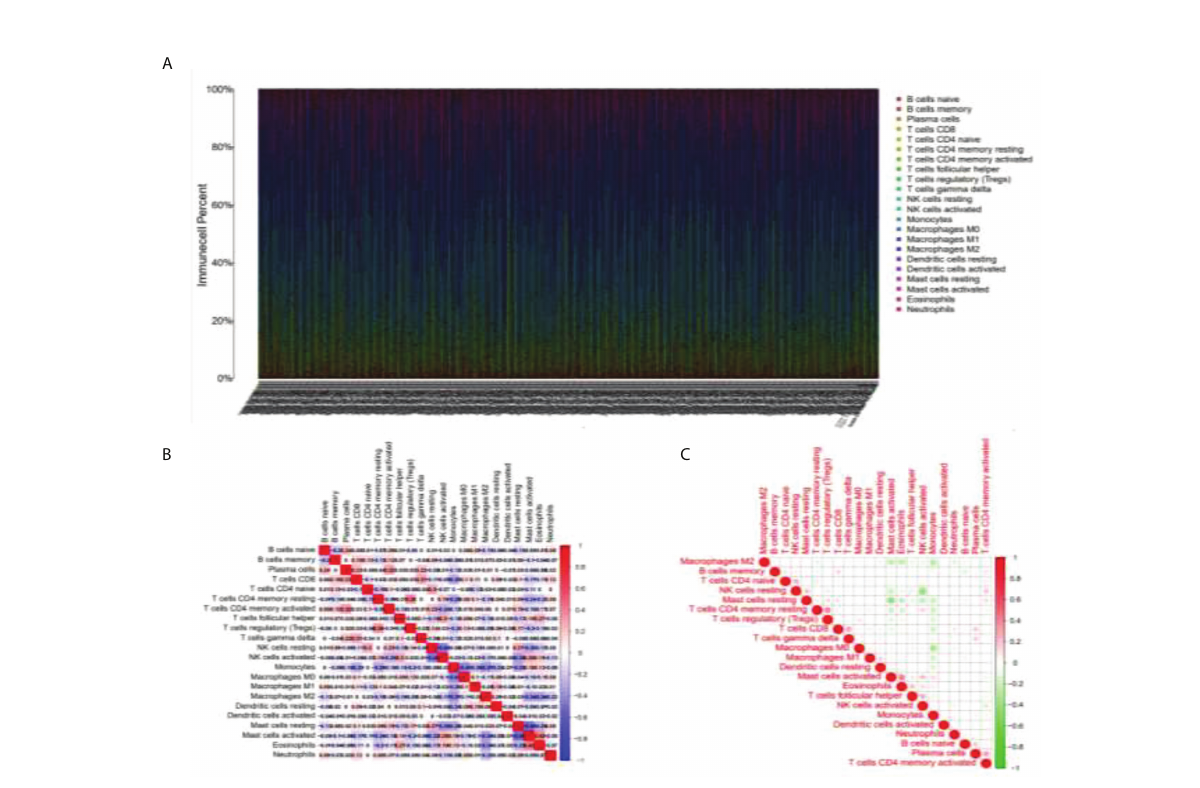
FIGURE 1 Immunocyte analysis in LGG samples. (A) Figure line of immune cell content in different LGG samples. (B, C) The selected immune cells were subjected to Spearman analysis and a correlation analysis of immune factors was carried